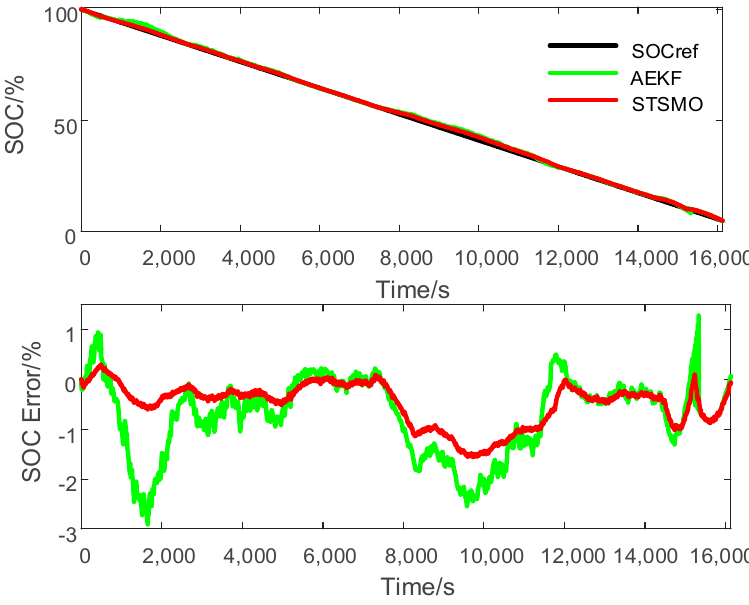
Figure 14. SOC estimation for 0.2 C constant current discharge (CCD) profile. AEKF: adaptive extended Kalman filter.